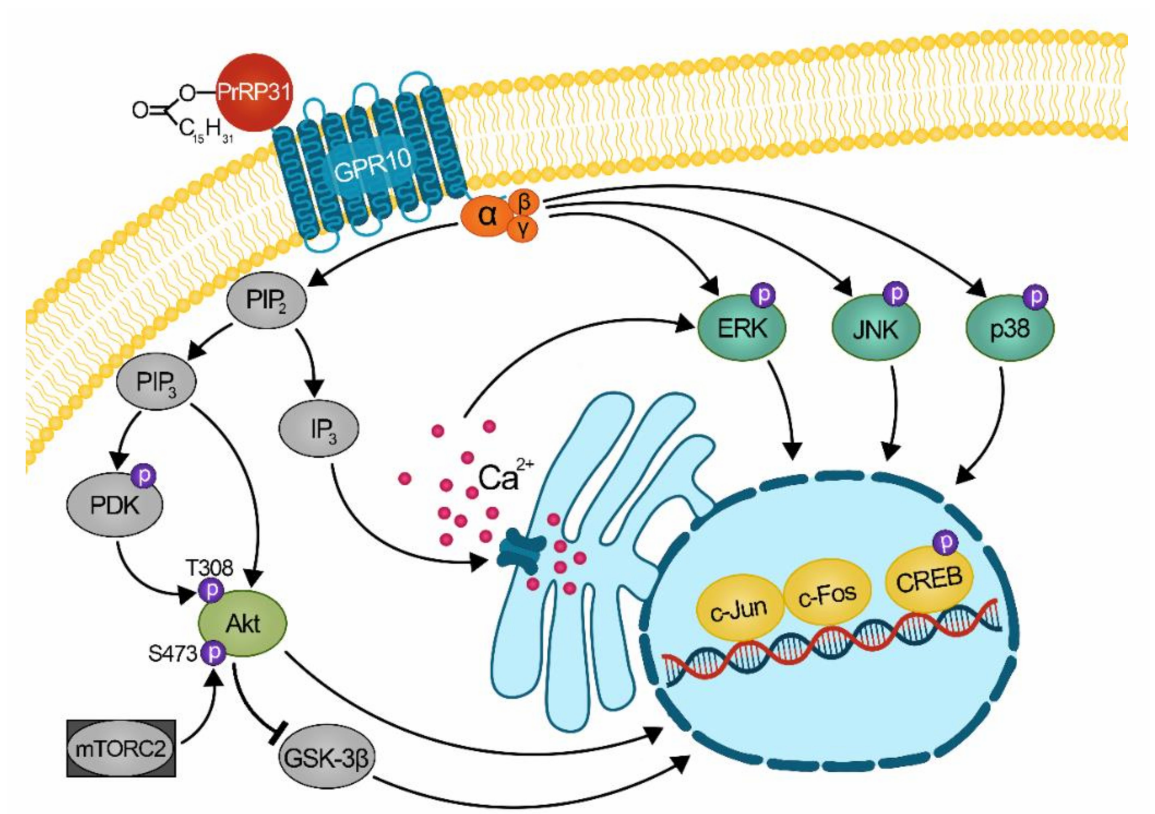
Figure 7. Scheme of mechanism of action of palmitoylated PrRP31 analogs at GPR10: ERK, extracellular signal-regulated kinase; JNK, c-Jun N -terminal kinase; CREB, cAMP-responsive element binding protein; PIP 2 , phosphatidylinositol 4,5-bisphosphate; IP 3 , inositol 1,4,5-triphosphate; PIP 3 , phosphatidylinositol (3,4,5)-trisphosphate; PDK, phosphoinositide- dependent kinase 1; Akt, protein kinase B; mTORC2, mammalian target of rapamycin complex 2; GSK-3 β , glycogen synthase kinase-3 β